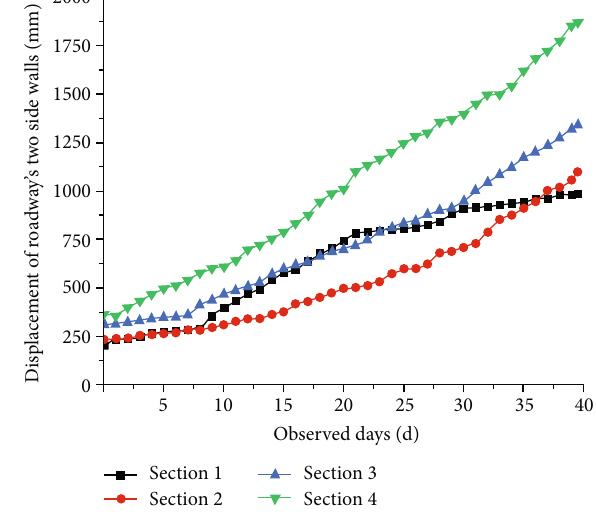
Figure 5: Convergence of the haulage